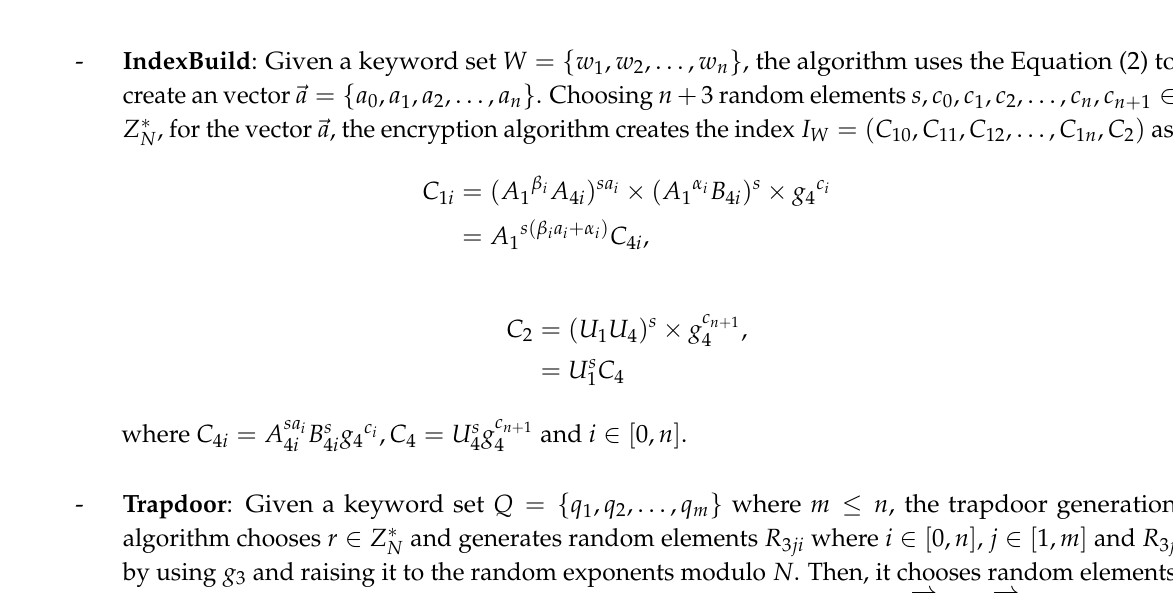
algorithm chooses r ∈ Z ∗ and generates random elements R 3 ji where i ∈ [ 0, n ] , j ∈ [ 1, m ] and R 3 N